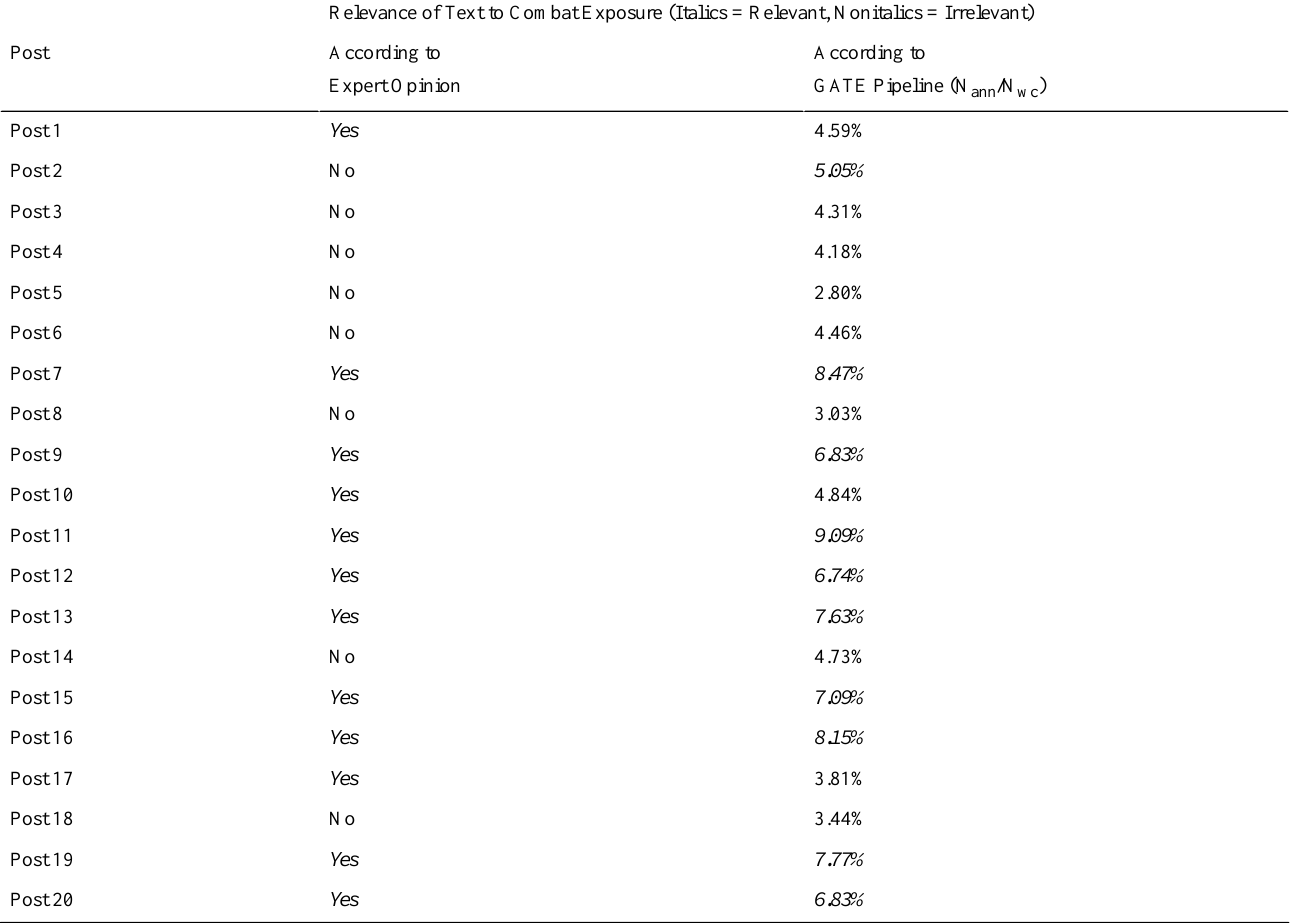
According to GATE Pipeline (N ann /N wc